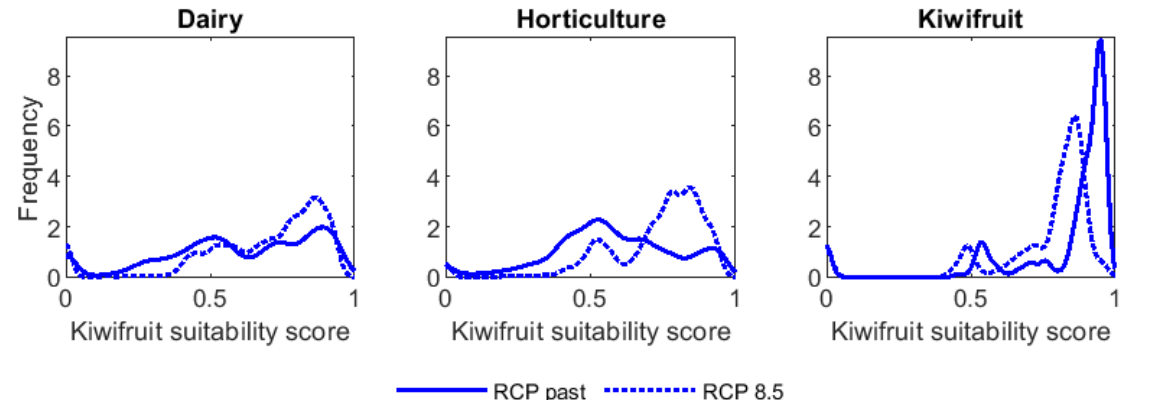
Figure 8. Changes in kiwifruit suitability (Representative Concentration Pathway (RCP) past vs. RCP 8.5) by current land use. Horticulture represents horticultural industries other than apple and kiwifruit.